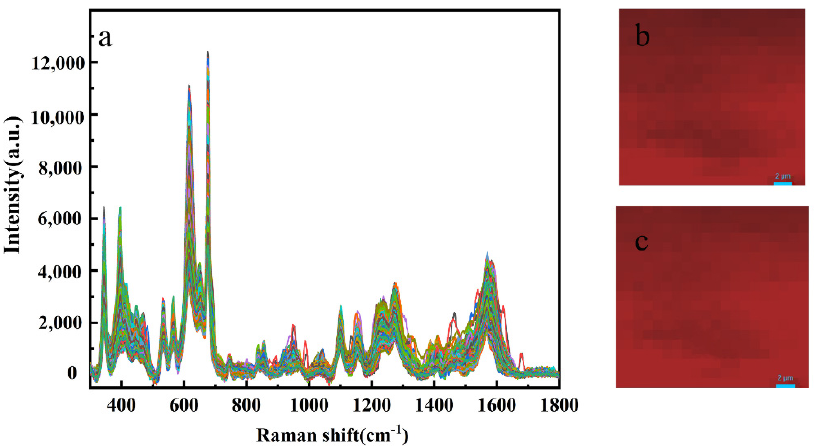
Figure 11. ( a ) SERS spectra of one apple surface sample treated with 1 mg L − 1 mixed pesticide. ( b ) The SERS mapping image at 675 cm − 1 . ( c ) The SERS mapping image at 392 cm − 1.